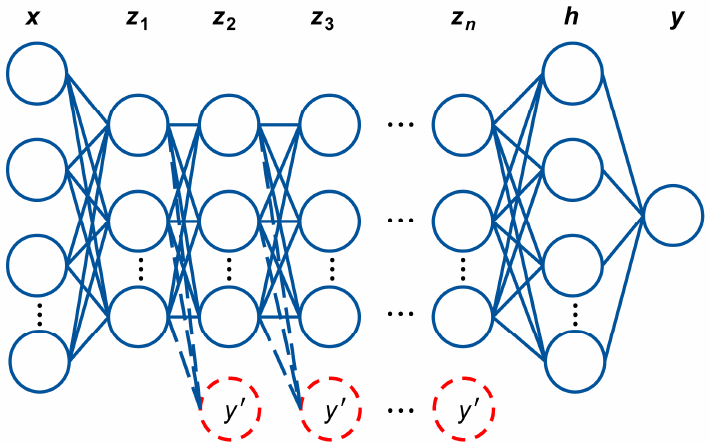
Figure 4. The stacked supervised autoencoder combined with the kernel extreme learning machine structure [101].